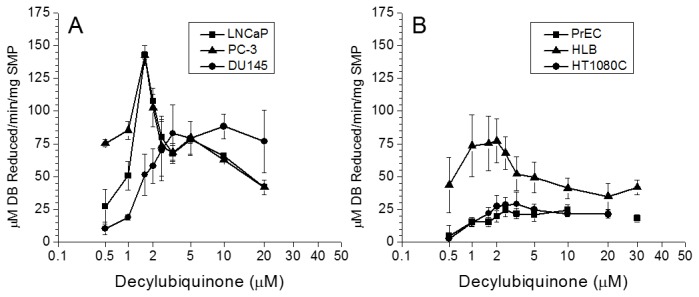
Dependence of Complex I activity on concentration of Decylubiquinone (DB) in submitochondrial particles from normal human PrEC and HLB cells, human prostate cancer cell lines PC-3, DU145, LNCaP and human fibrobsarcoma HT1080 cells.Incubation conditions are described in Methods. SMP (0.15 mg) were incubated with various concentrations of DB for 5 min at 30oC; the reaction was started by addition of 1 mM NADH.Panel A: the rate of DB reduction by SMP from LNCaP (■), PC-3 (●), and DU145 (▲) cells.Panel B: the rate of DB reduction by SMP from PrEC (■), HLB (▲), and HFS (●) cells.